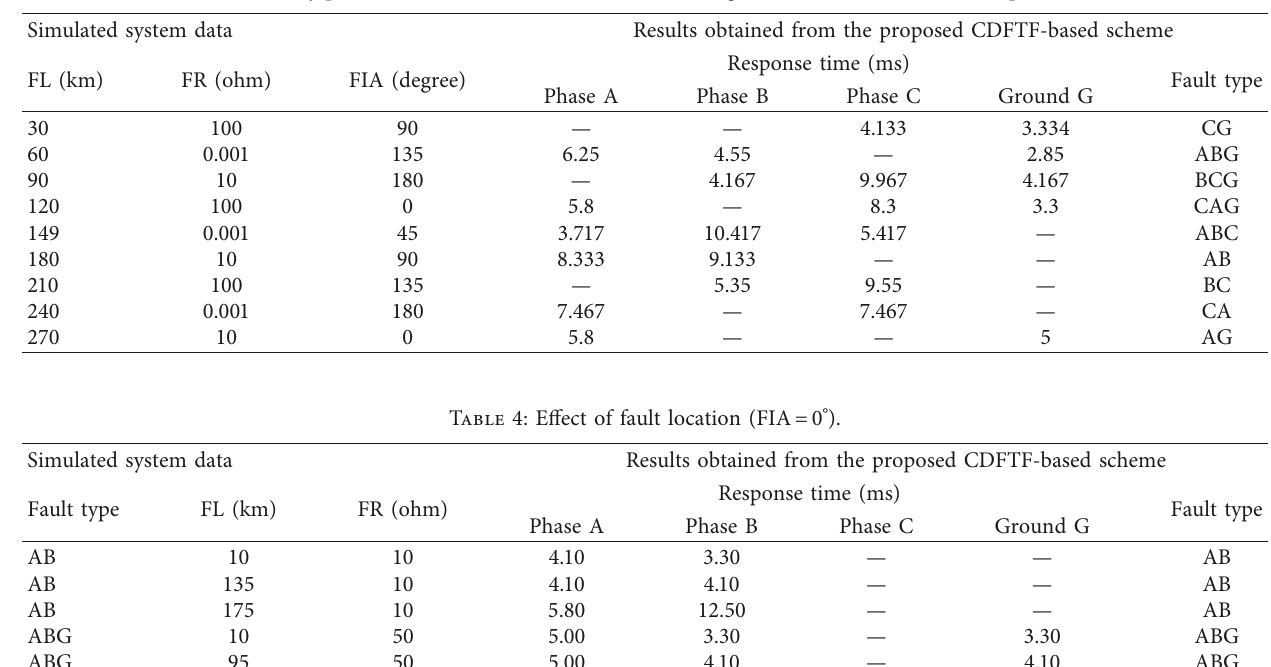
Table 3: Faulty phase detection and fault classification using FFC with variations in fault